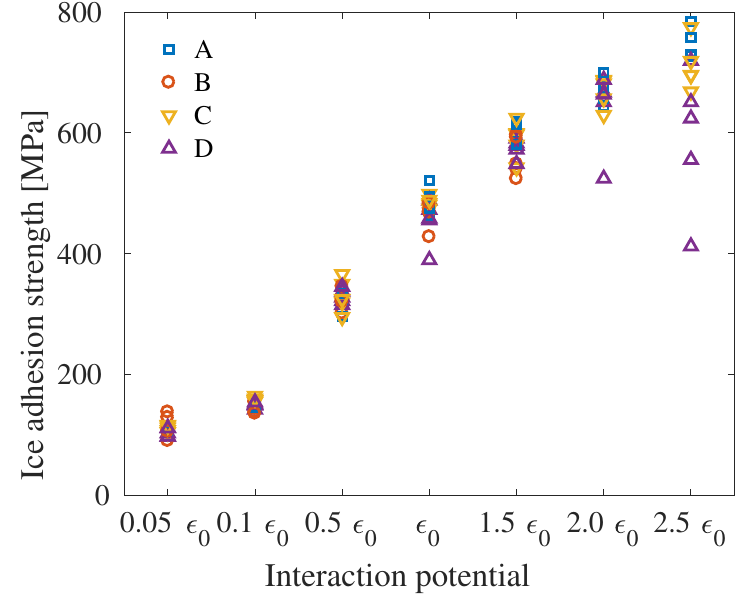
Figure 9. Ice adhesion strength as function of interaction energy ε for all system sizes. Separate figures can be seen in Figure